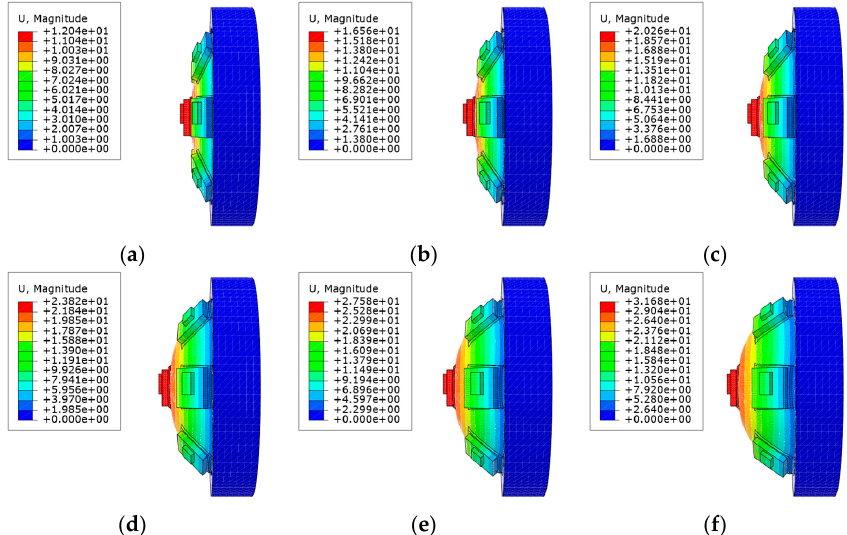
Figure 5. The ABAQUS software simulates the model state effect diagram of SAM under different air pressures. ( a – f ) is the simulation effect diagram of the SAM from relative ambient air pressure 6 kPa–36 kPa with a gradient of 6 kPa.